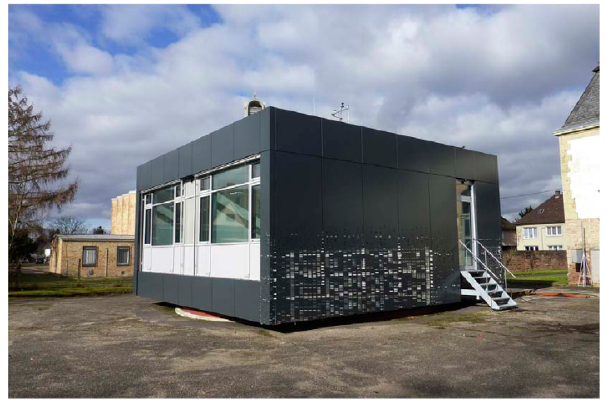
Figure 1. The ‘LOBSTER’ test facility: view from outside (a selected image).